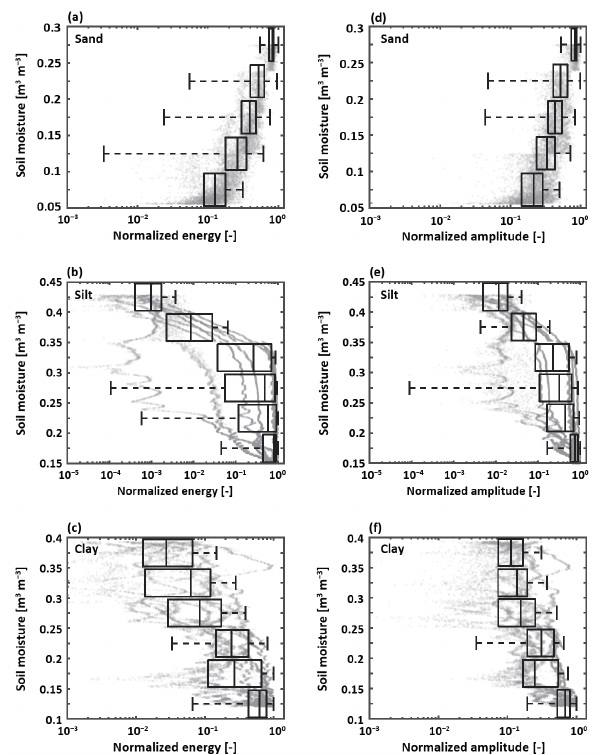
Figure 7. Box plots for wave properties with the soil moisture interval of 0.05 m 3 m − 3 . The left column shows normalized energy for ( a ) sand, ( b ) silt, and ( c ) clay. The right column shows normalized amplitude for ( d ) sand, ( e ) silt, and ( f ) clay . The gray dots represent the estimated wave properties from the 8